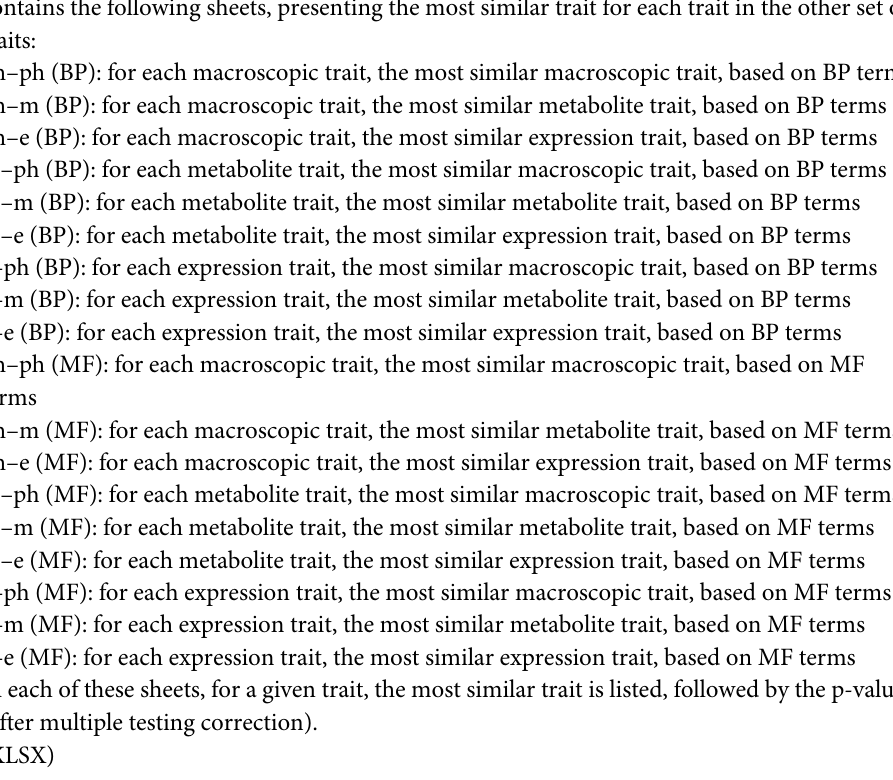
S1 Fig. Semantic similarity between traits. Histograms of the maximum semantic similarity for each trait with any other trait of either the same type or of different type, based on either BP or MF terms. (A) Macroscopic traits, based on BP. (B) Metabolic traits, based on BP. (C) Expression traits, based on BP. (D) Macroscopic traits, based on MF. (E) Metabolic traits, based on MF. (F) Expression traits, based on MF. In all panels, red indicates maximum simi- larity to macroscopic traits, blue maximum similarity to metabolic traits, and green